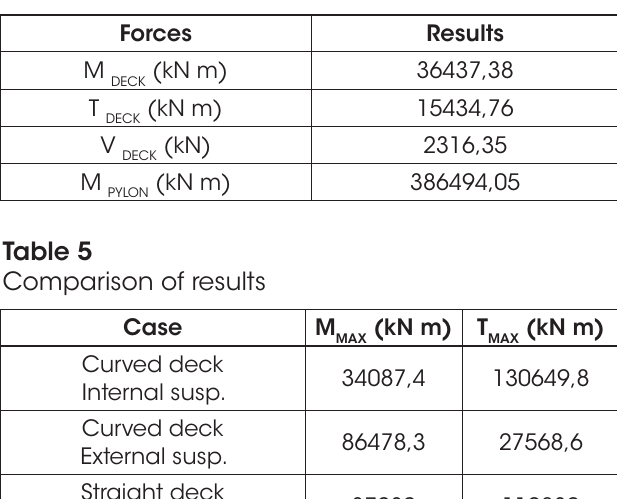
Moments and shear force summary in curved deck: bilateral suspension